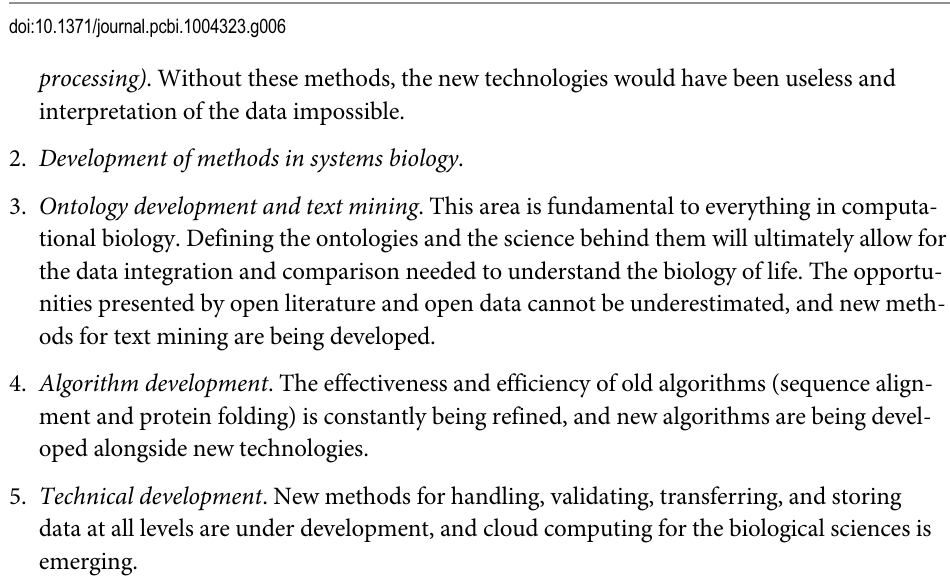
Fig 6. Janet Thornton. Senior scientist and outgoing director of